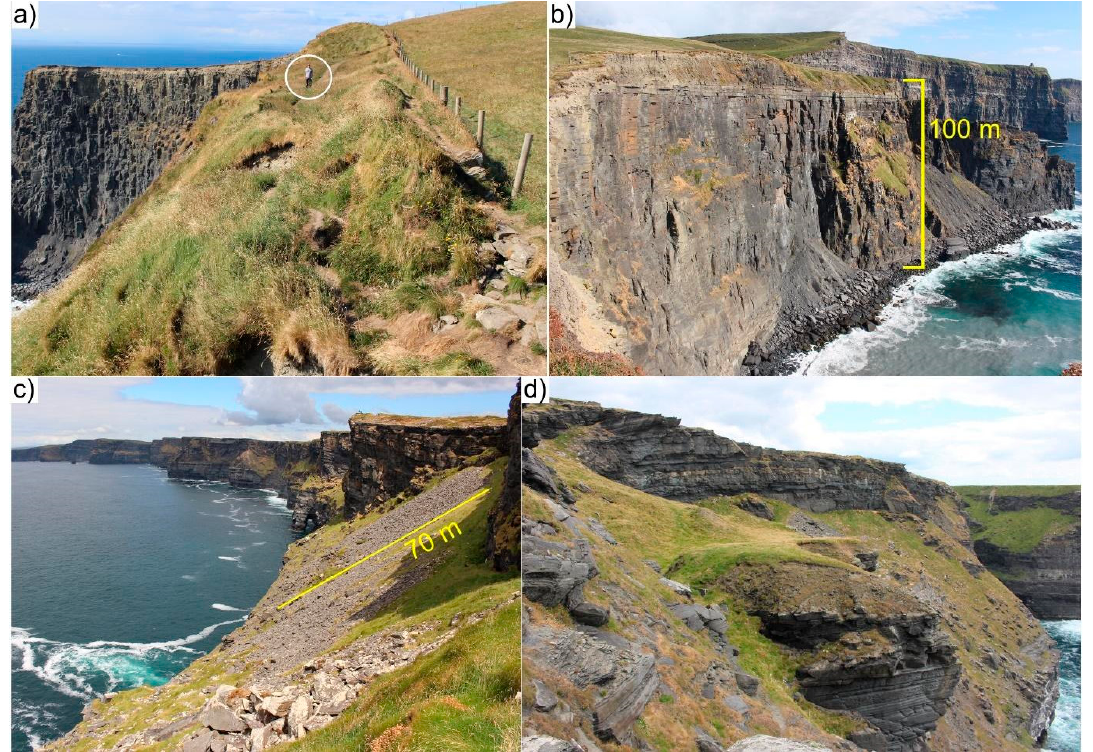
Figure 14. Field evidence of instability at localities along the Cliffs of Moher where motion was detected by PS-InSAR. ( a ) Top of the cliff at locality ‘i’, as seen from the south. Note person for scale. ( b ) The cliff face at locality ‘i’, as seen from the north. Note the fresh debris fan at the cliff